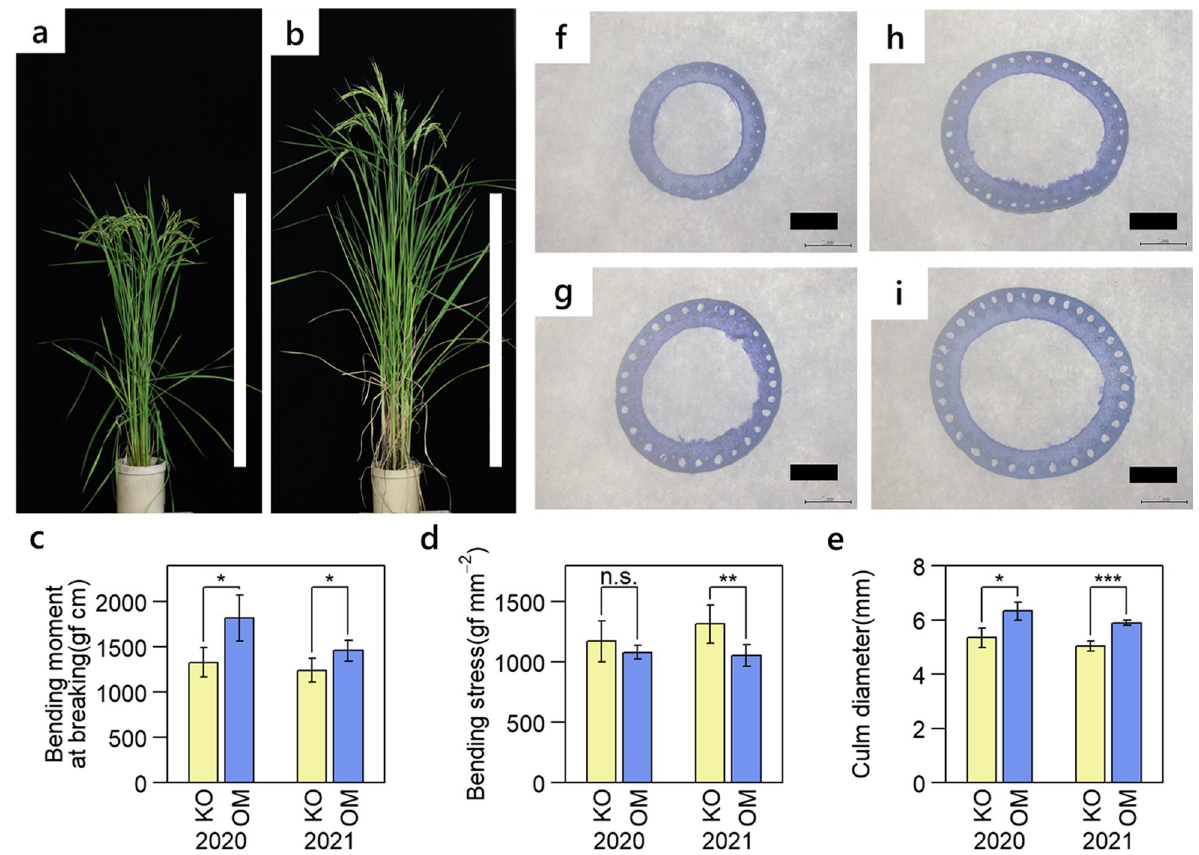
Fig. 1 Comparison of traits associated with culm strength in Koshihikari and Omachi. a , b Plant appearances of ( a ) Koshihikari and ( b ) Omachi. White bar indicates 1 m. c – e . Comparison of the traits related to culm strength in the 5th internode. The values indicate averages of 3 and 6 replications in 2020 and 2021, respectively. Error bars indicate standard deviation. A t-test was performed assuming equal variances between two varieties, and p < 0.001, p < 0.01, p < 0.05, p 0.05 were marked with ***, **, *, n.s., respectively. f – i . Picture of cross-sections in ( f ) the 4th internode of ≥ Koshihikari, g the 5th internode of Koshihikari, h the 4th internode of Omachi, and i the 5th internode of Omachi. Black bar indicates 2